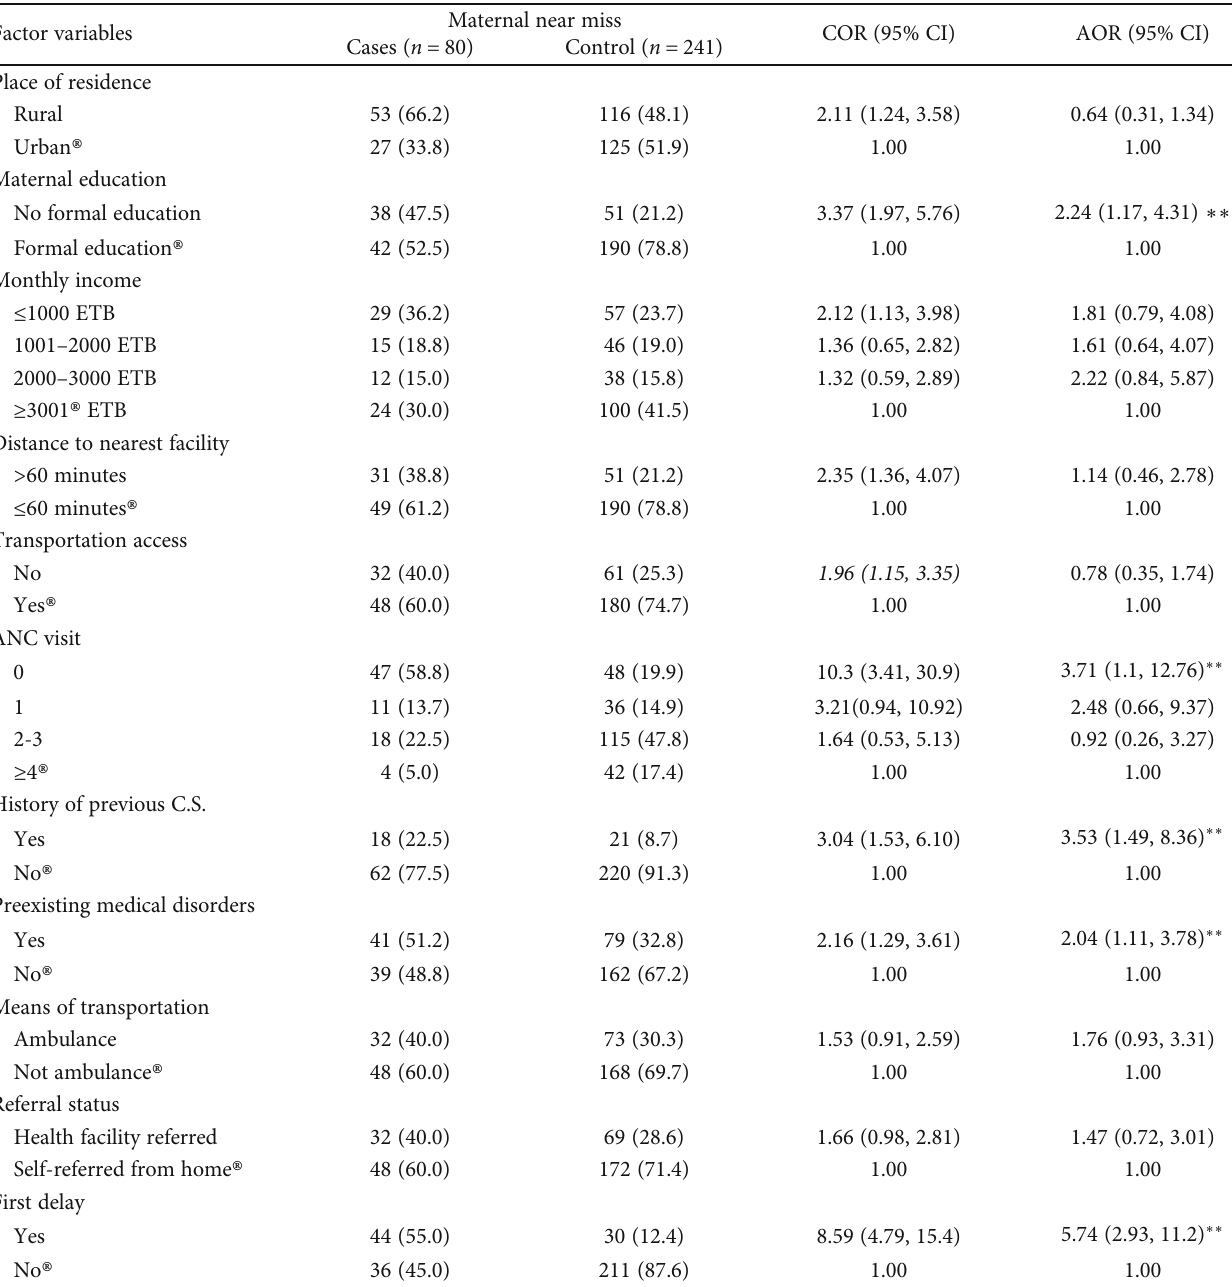
Table 4: Factors associated with maternal near miss in multivariable logistic regression analysis, among women in West Arsi zone public hospitals, Ethiopia,